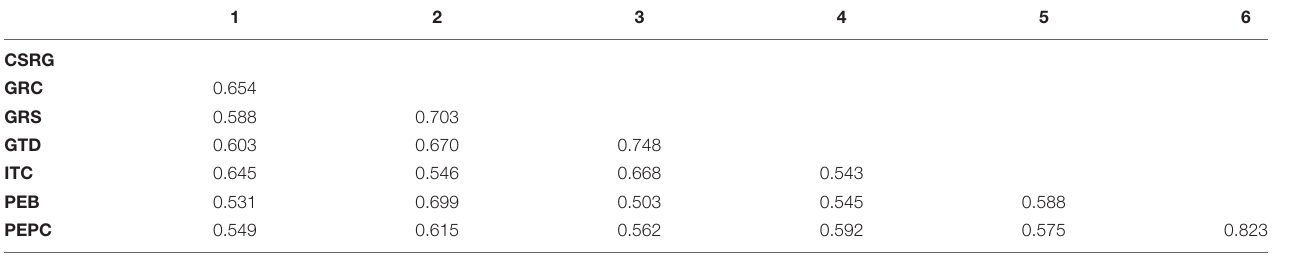
TABLE 5 | Heterotrait-Monotrait (HTMT) ratio.